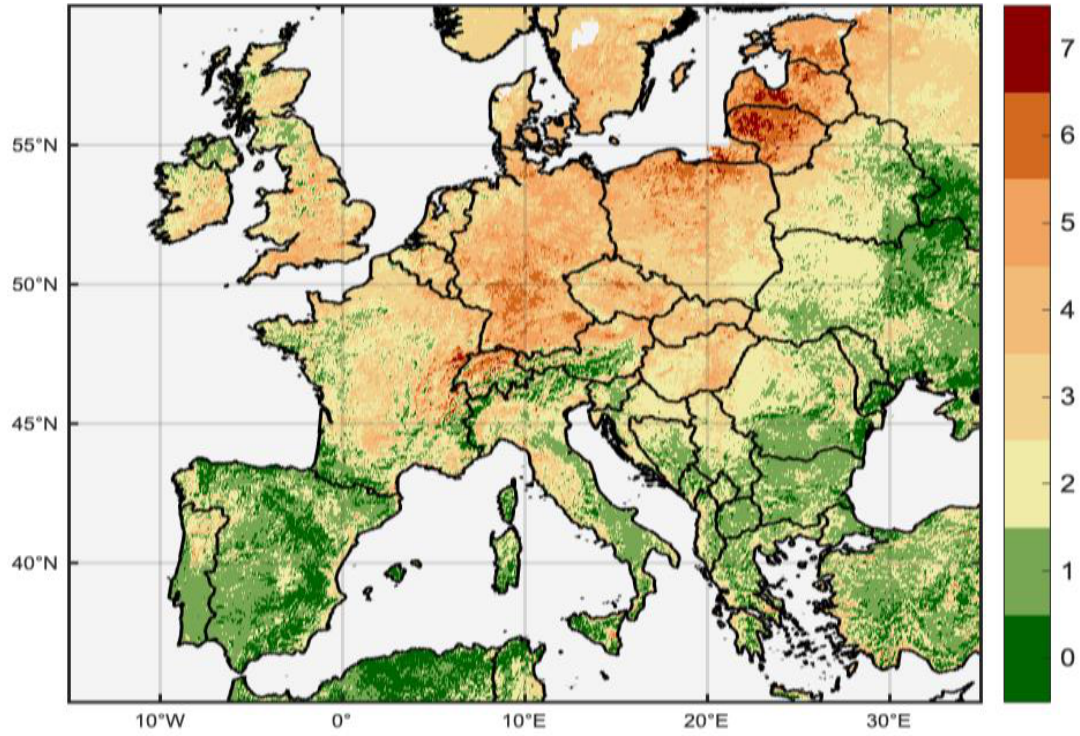
Figure 4. Spatial patterns of the number of months in 2018 which recorded the highest monthly MSG LST anomaly value regarding the 2004 to 2019 period.